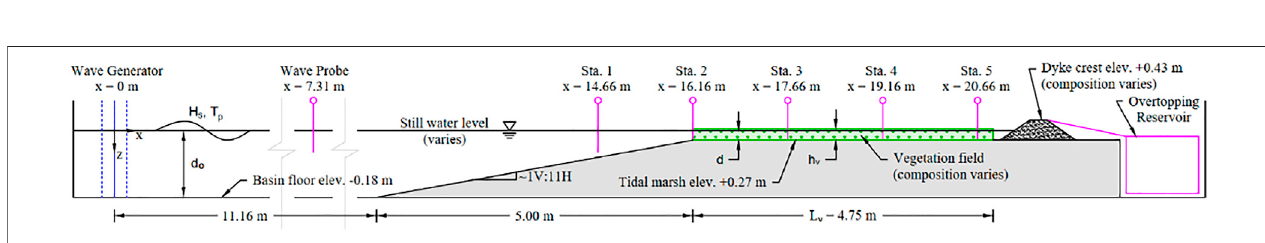
FIGURE 2 | De fi nition sketch of the experimental setup (Scale